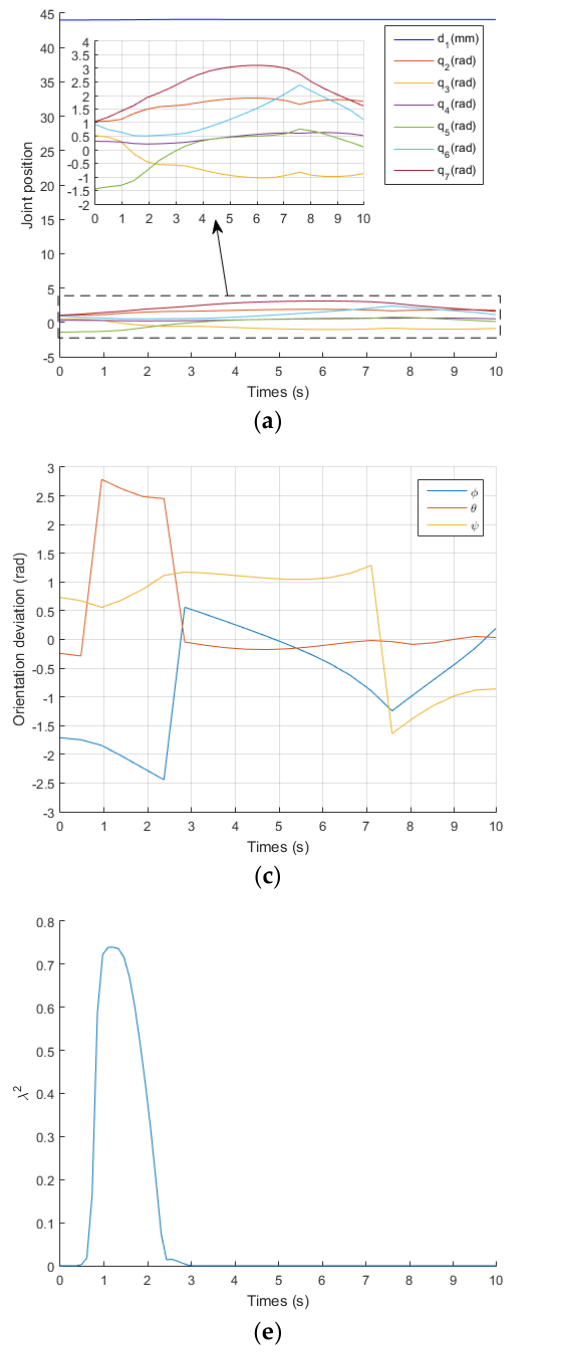
Figure 9. Simulation results of the proposed IWGPM (no joint position limits). ( a ) the change curve of joint position; ( b ) the change curve of position deviation; ( c ) the change curve of orientation deviation; ( d ) the change curve of σ min ; ( e ) the change curve of λ 2 .